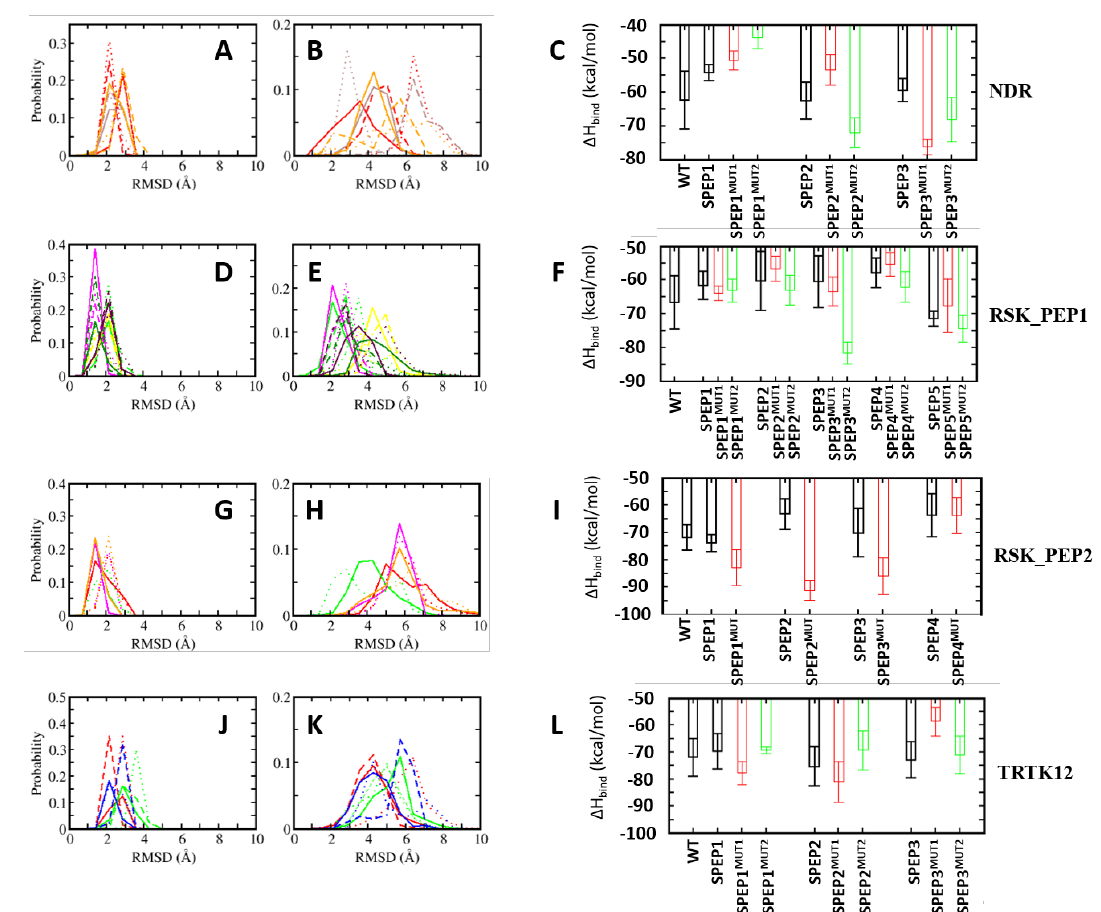
Figure 9. Distribution of root mean squared deviations (RMSD) of ( A , D , G , J ) S100B( ββ )and ( B , E , H , K ) the bound stapled mutant peptides (( A , B ): S100B( ββ )–NDR; ( D , E ): S100B( ββ )–RSK_PEP1; ( G , H ): RSK_PEP2; ( J , K ): S100B( ββ )-TRTK12 com- plexes). Different colours correspond to the different stapled wildtype peptides (continuous) and stapled mutant peptides ((MUT/MUT1: dashed; MUT2: dotted lines) (NDR: red: SPEP1, orange: SPEP2, grey: SPEP3) (RSK_PEP1: green: SPEP1, yellow: SPEP2, magenta: SPEP3, dark green: SPEP4, maroon: SPEP5) (RSK_PEP2: red: SPEP1, green: SPEP2, orange: SPEP3, magenta: SPEP4) (TRTK12: red: SPEP1, green: SPEP2, blue: SPEP3)). ( C , F , I , L ) Binding free energies of the interactions of S100B( ββ ) with each stapled mutant peptide were calculated with the MMPBSA approach (see Methods) using the conformations sampled during the MD simulations of the S100B( ββ )–stapled mutant peptide